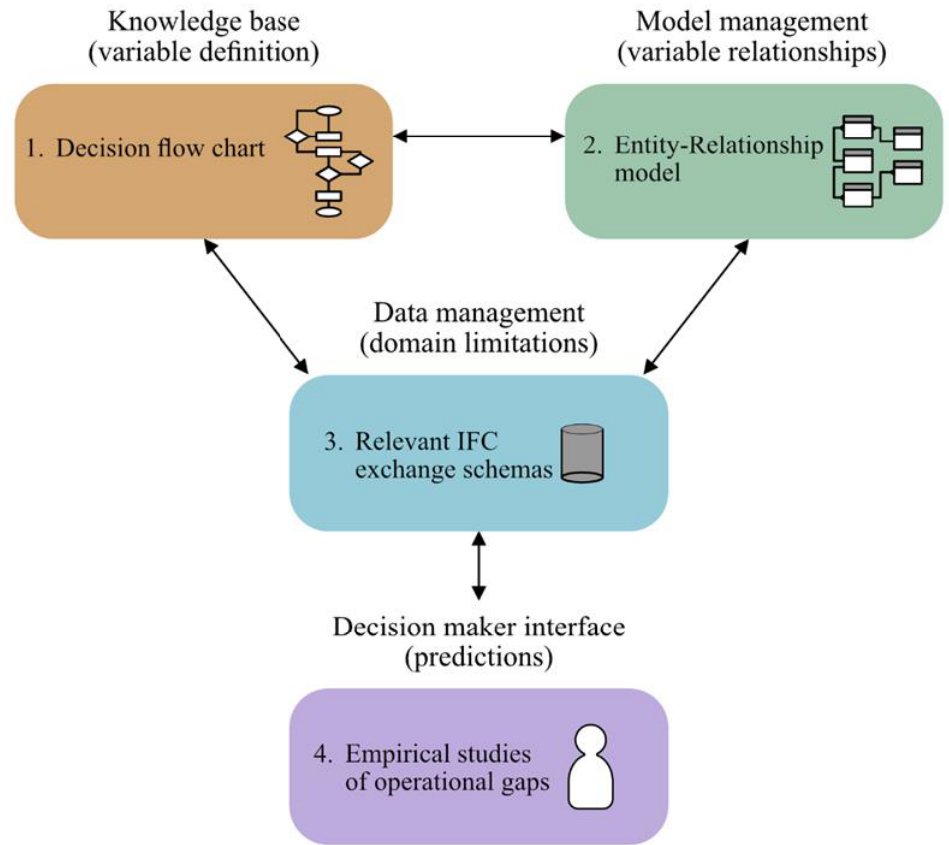
Figure 3. Description of the research process. The numbers indicate the order in which the investigations were performed.